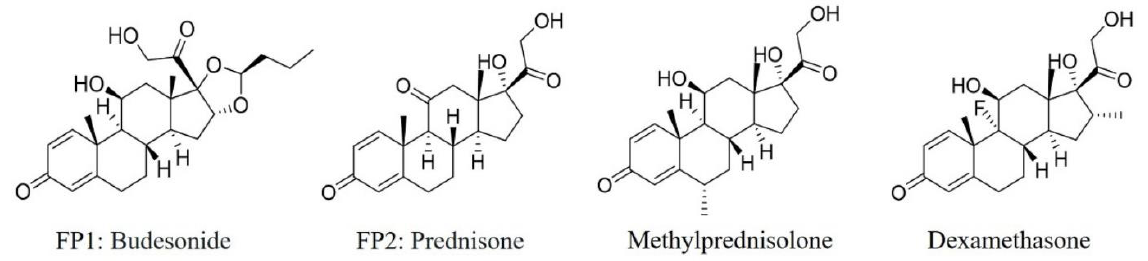
Figure 5. Structure of two false positives and two DITP toxicants.